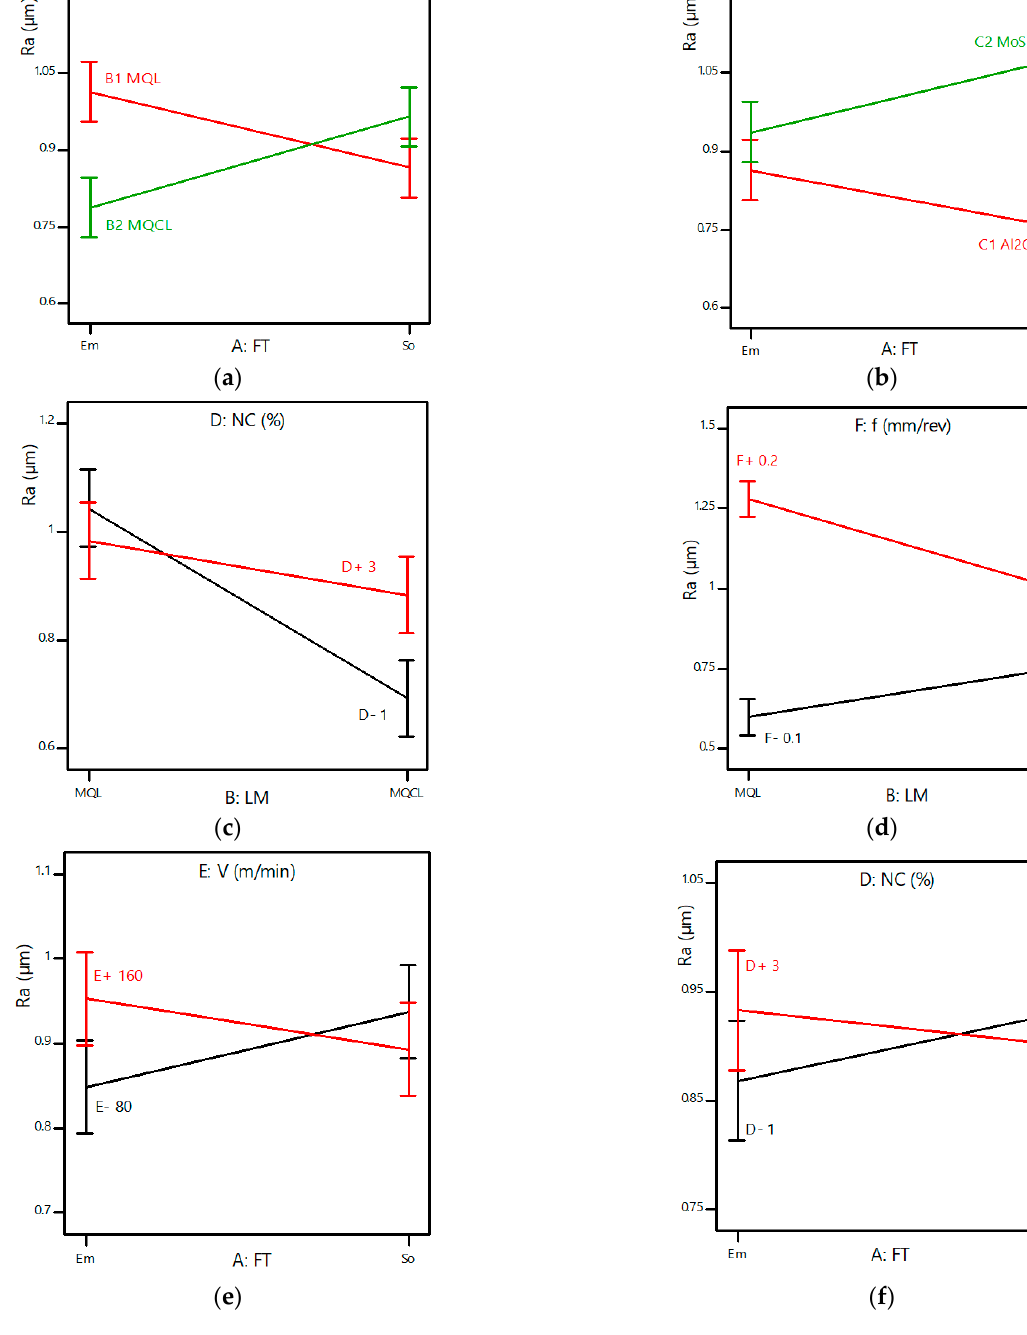
Figure 7. Interaction effects between input parameters on surface roughness: ( a )—FT*LM; ( b )— FT*NP; ( c )—LM*NC; ( d )—LM*f; ( e )—FT*V; ( f )—FT*NC.